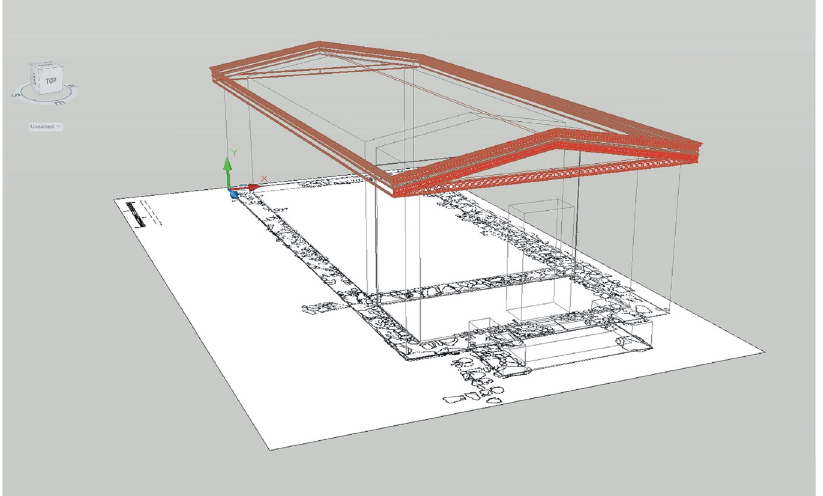
Figure 5. Tempietto H. Wireframe reconstruction superimposed on the excavation plan in CAD (Jari Pakkanen)